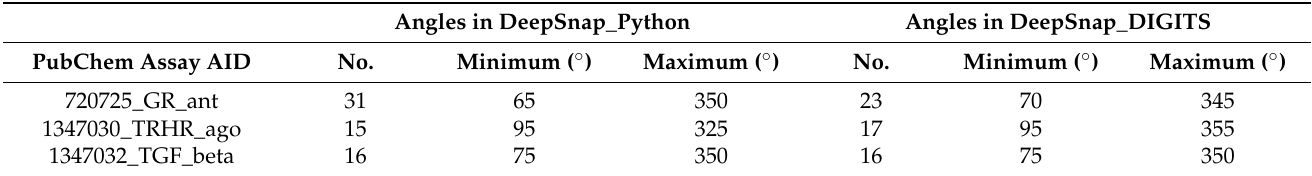
Table 1. Angles used in DeepSnap on modeling of the three MIE targets.